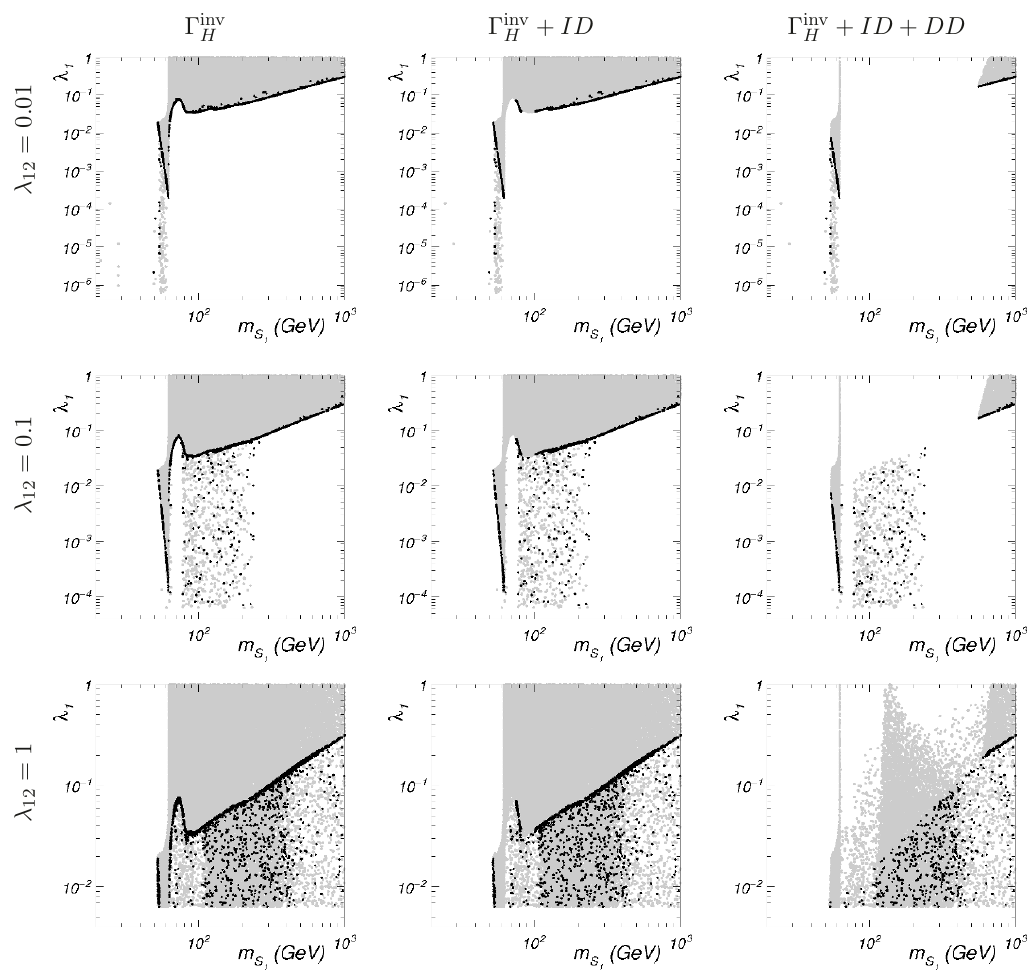
Figure 7 . Effect of the experimental constraints in the model. From up to down, we have fixed λ 12 = 0 . 01 , 0 . 1 , 1, and λ 2 = λ 2 12 / (4 π ) 2 . In all the plots, black (gray) points correspond to those where Ω h 2 = 0 . 119 incorporates only constraints from lifetime of S 2 and invisible decay width of the Higgs boson. The central column includes also the indirect detection (dSph and gamma ray lines). Finally, the bottom row includes the bound from the LUX